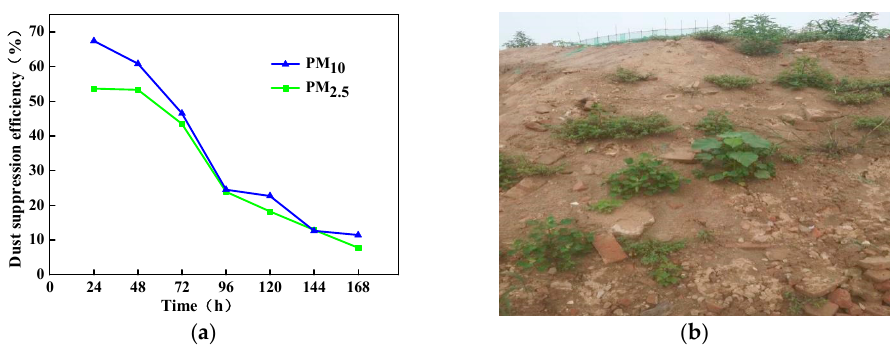
Figure 7. ( a ) Dust suppression efficiency at construction sites, and ( b ) surface state of the waste area on day 15 after dust suppression.